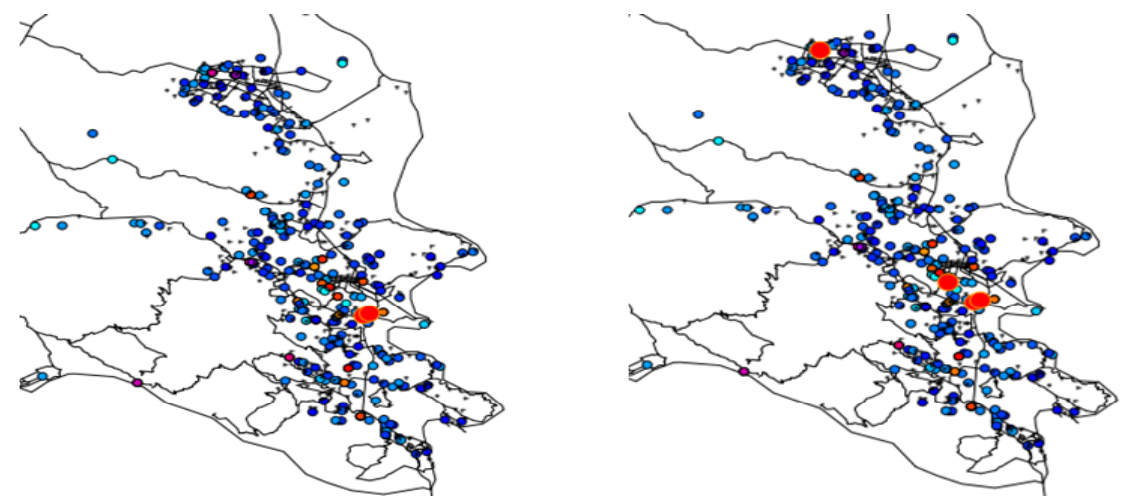
Figure 9. Local clusters of breast cancer cases (large red circles) for twenty year ( left ) and fifteen year ( right ) residents of Marin County, California. The observed clustering is statistically significant when residential mobility and significant risk factors and covariates are accounted